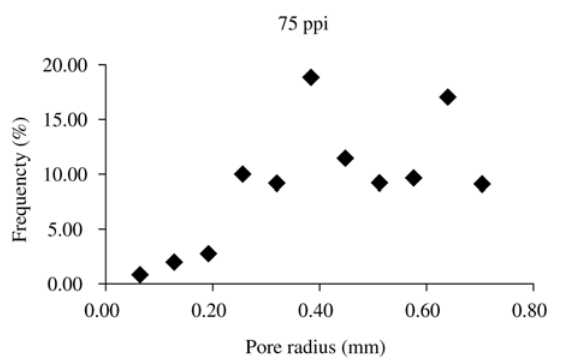
Figure 7. 75 ppi ceramic foam pore size distribution.